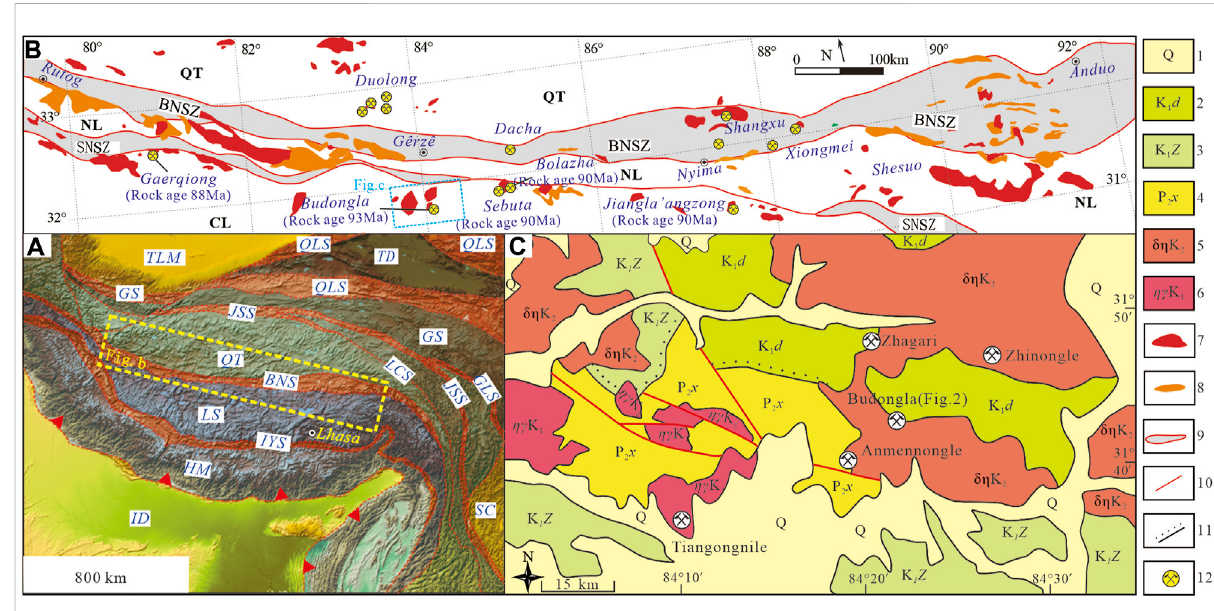
FIGURE 1 Regional geological and mineral maps [ (A) , after Liu et al., 2015; (B) , after Tang et al., 2014; Liu et al., 2017; Liu et al., 2022b; Huang et al., 2021b; (C) , after Liu et al., 2021b] 1 — Quaternary; 2 — Lower Cretaceous Duoni Fm; 3 — Lower Cretaceous Zenong Gr; 4 — Lower Permian Xiala Gr; 5 — Late Cretaceous monzodiorite;6 — LateCretaceous monzogranite; 7 — Ophiolitemelange;8 — Cretaceousintrusiverocks;9 — Cretaceousvolcanic rocks; 10 — Fault; 11 — Unconformity boundary; 12 — Gold deposit (point); TLM — Tarim block; QLS — Qilian suture zone; WQS — Western Kunlun